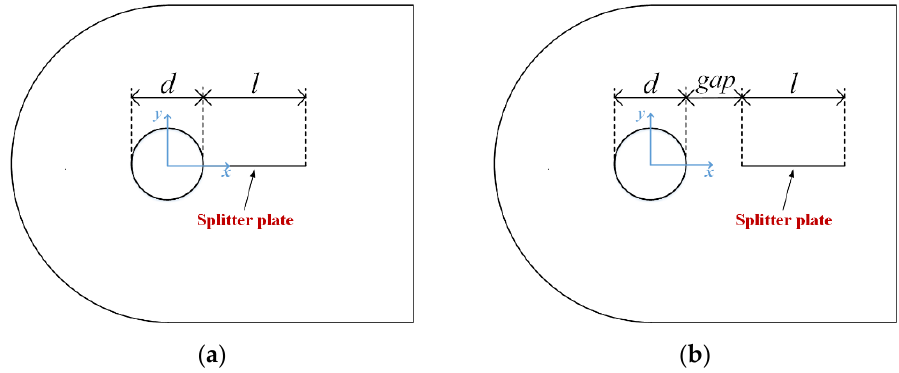
Figure 1. Schematic of the arrangement: ( a ) Cylinder-Spoiler; ( b )